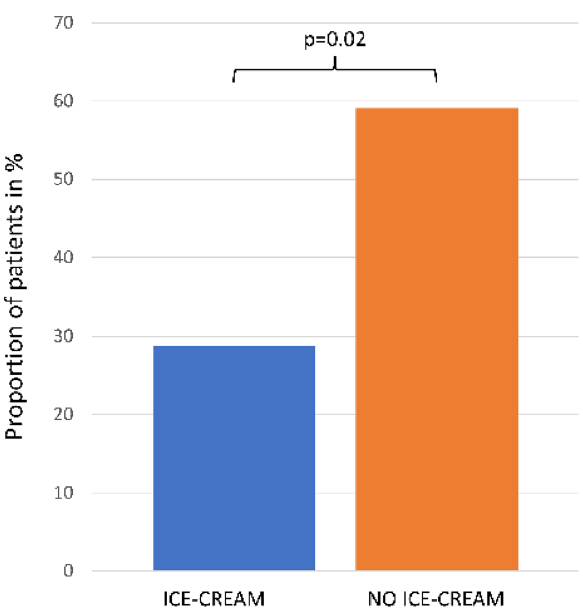
Figure 1. Proportion of patients with oral mucositis on and without ice-cream cryotherapy. 28.85% patients who received ice-cream cryotherapy developed OM, whereas 59.09% developed it in the group with no cryotherapy. In a multiple linear regression test cryotherapy remained a significant protective factor against OM ( p =